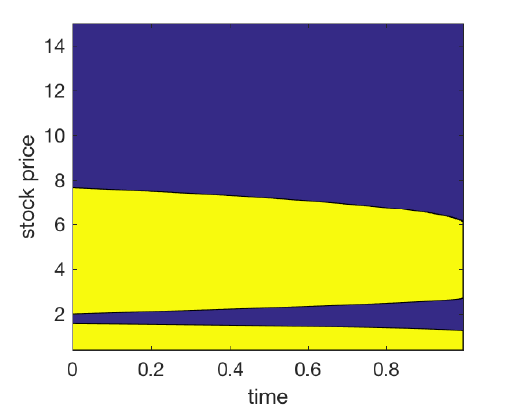
Figure 5. Optimal trading regions for stock liquidation under the two-point discrete distribution. The continuation regions are in yellow (light) color and the exercise regions are in blue (dark), and they are disconnected. Parameters: δ u = − δ d = 0.8, p u = p d = 0.5. Common parameters: X 0 = 1, r = 0.1, ¯ T = 1, T = 1.1, σ =